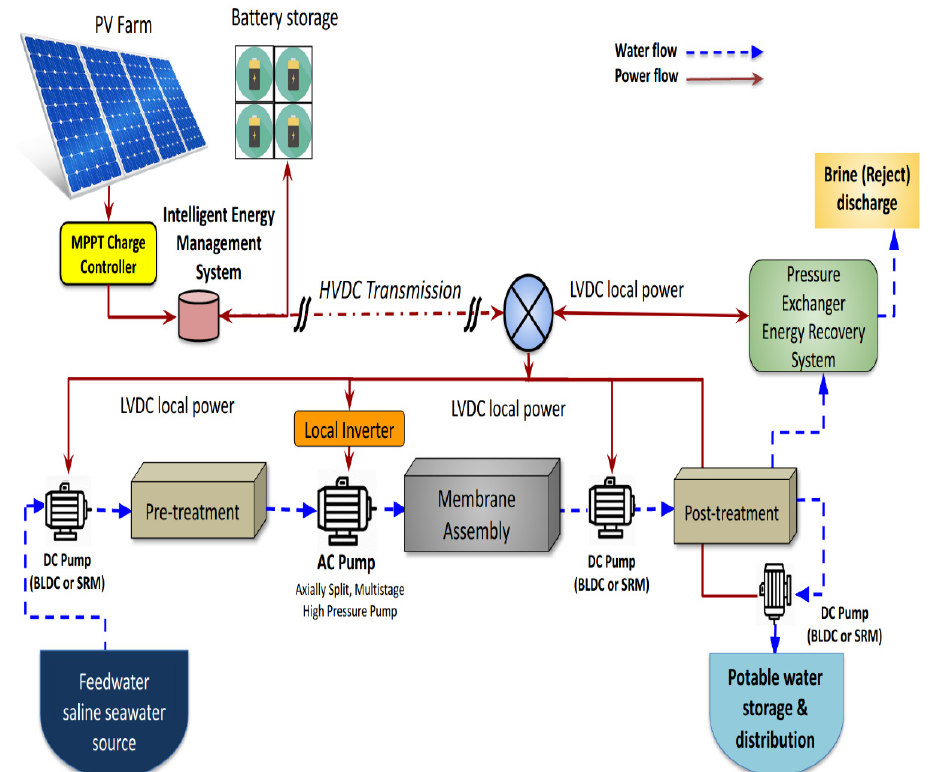
Figure 7. Proposed stand-alone desalination plant system design based on DC architecture. In this figure MPPT, BLDC and SRM represent Maximum Power Point Tracking, Brushless DC, Synchronous Reluctance Motor respectively.